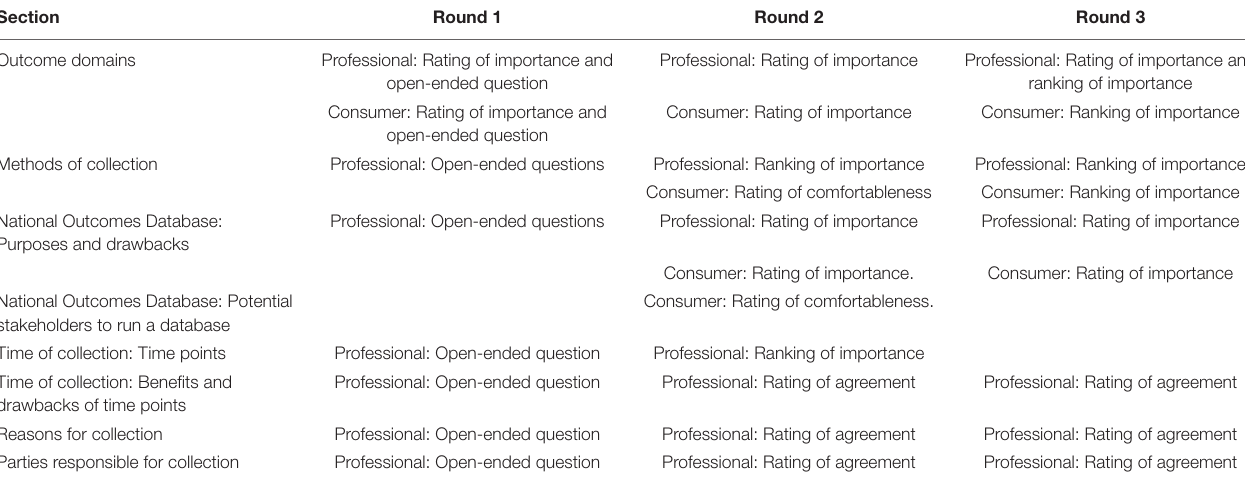
TABLE 2 | Types of response invited for each section of the Delphi review surveys. Section